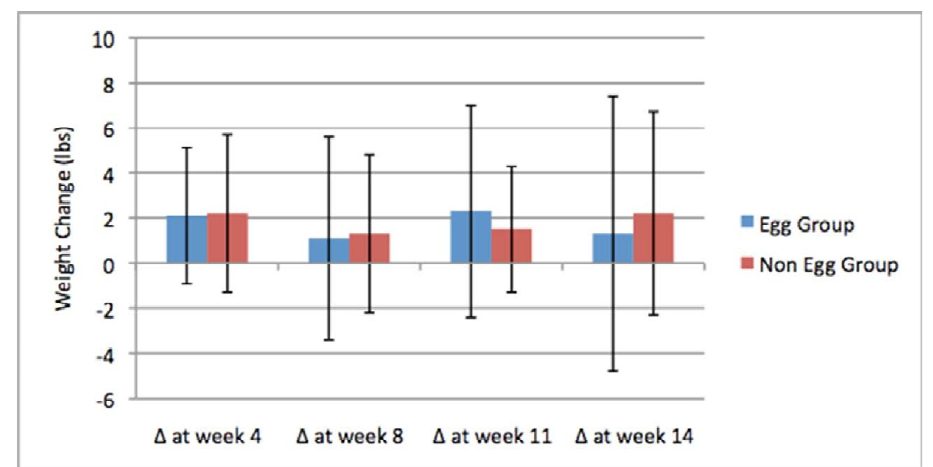
Figure 3. Time course of body weight changes.